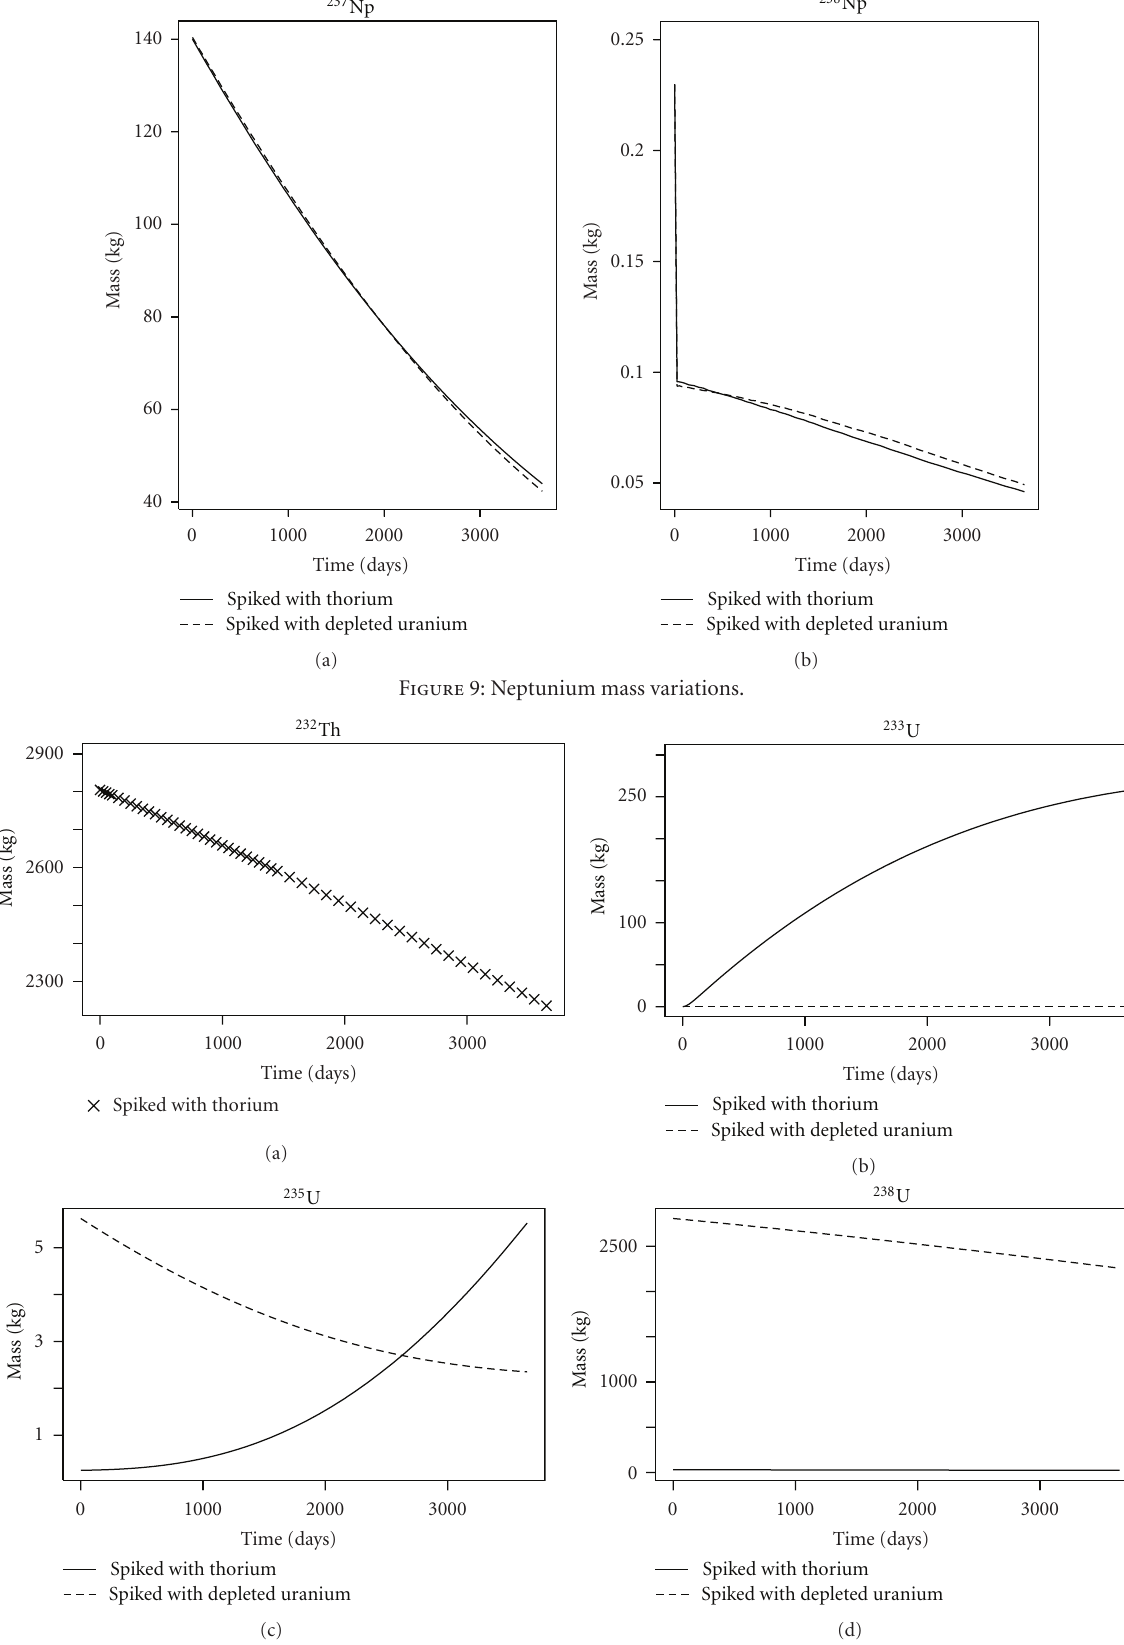
Figure 10: Thorium and uranium mass